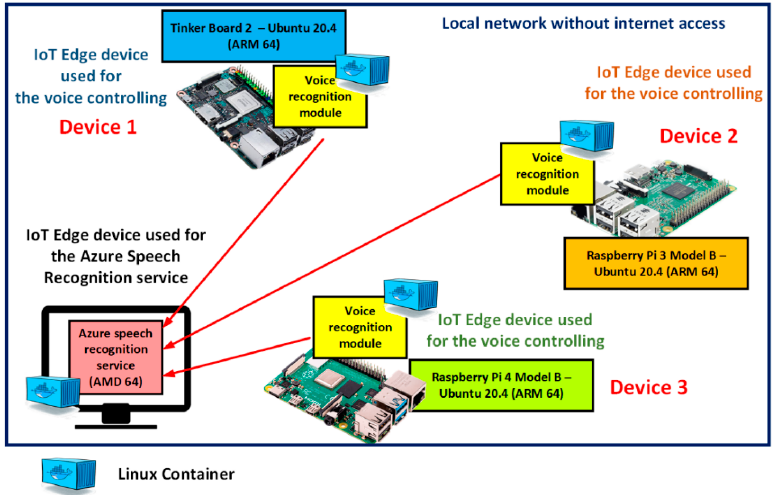
Figure 11. Three ways to connect many edge devices (Category I) on a local network to one single IoT edge device (Category II) running the Azure Speech Recognition service.